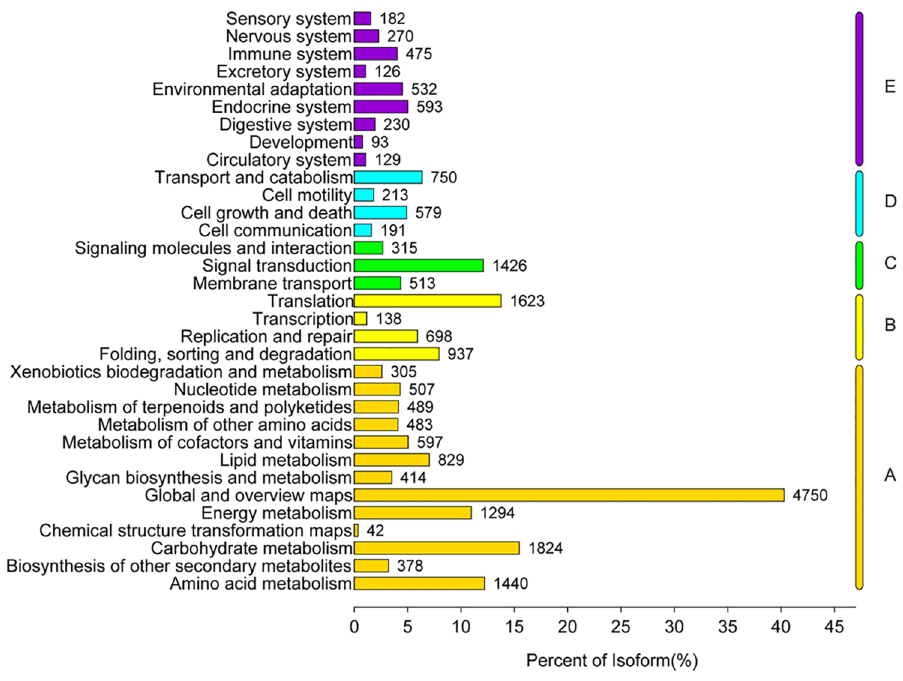
Fig 5. Classification map of KEGG metabolic pathway. A: Metabolism, B: Genetic information processing, C: Environmental information processing, D: Cellular processes, E: Organismal systems.